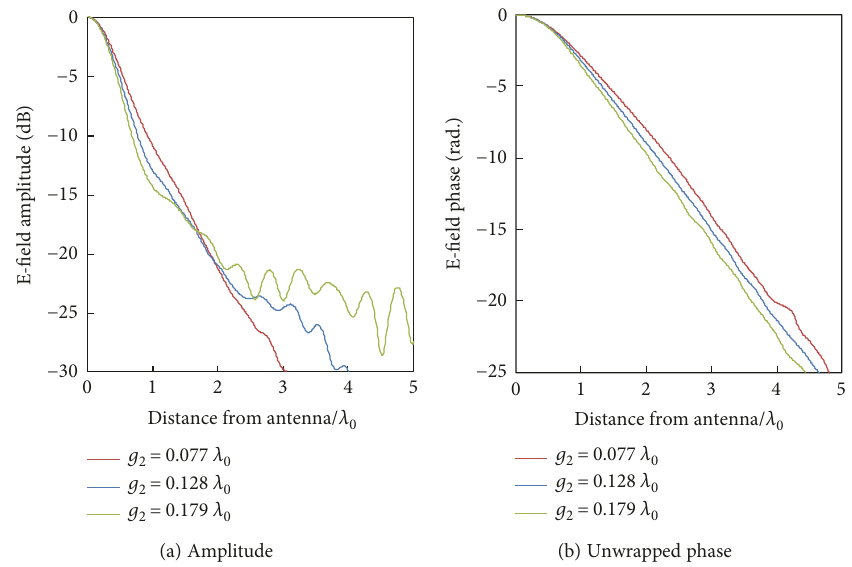
Figure 12: Normalized e- fi eld intensity distribution for the di ff erent corrugation depths.